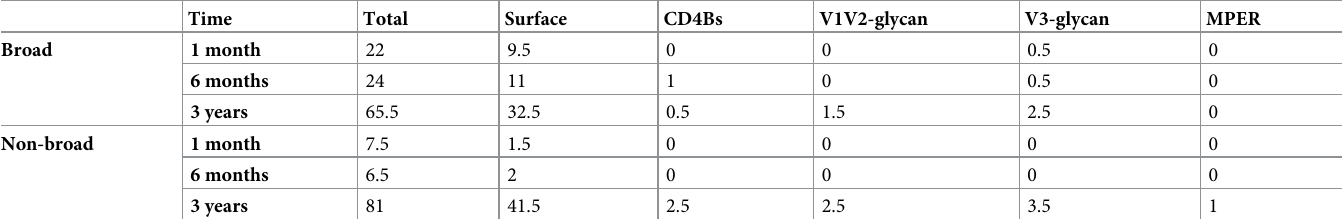
Table 1. Number of polymorphic sites in broad and non-broad neutralizers. Median numbers are listed for all Env sites and different subsets at different times after HIV-1 diagnosis in. individuals who developed. bnAbs or